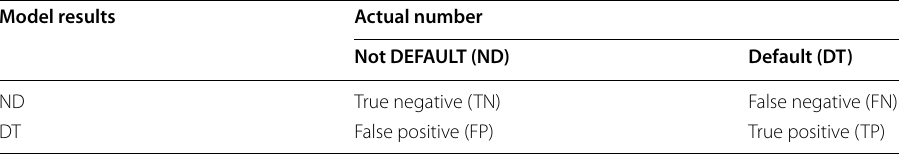
Table 12 Definitive matrix Model results